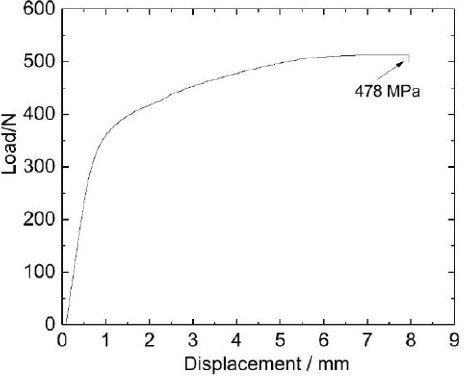
Figure 20. A typical load–displacement curve of the titanium main matrix specimen tested in 3-point